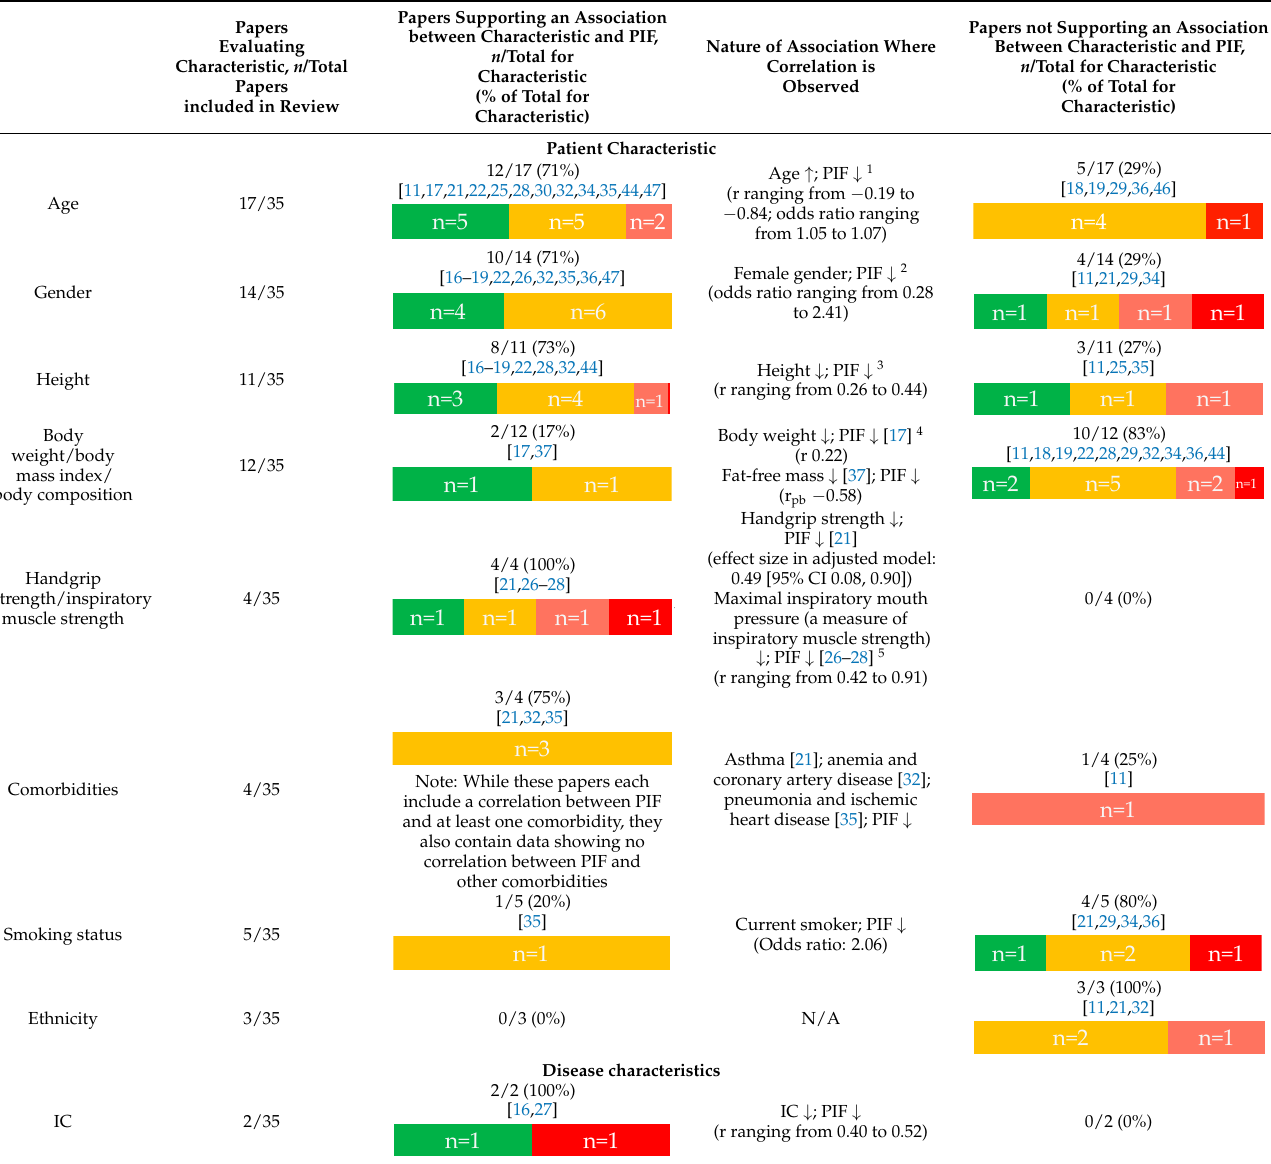
Table 1. Patient and disease characteristics associated with PIF.